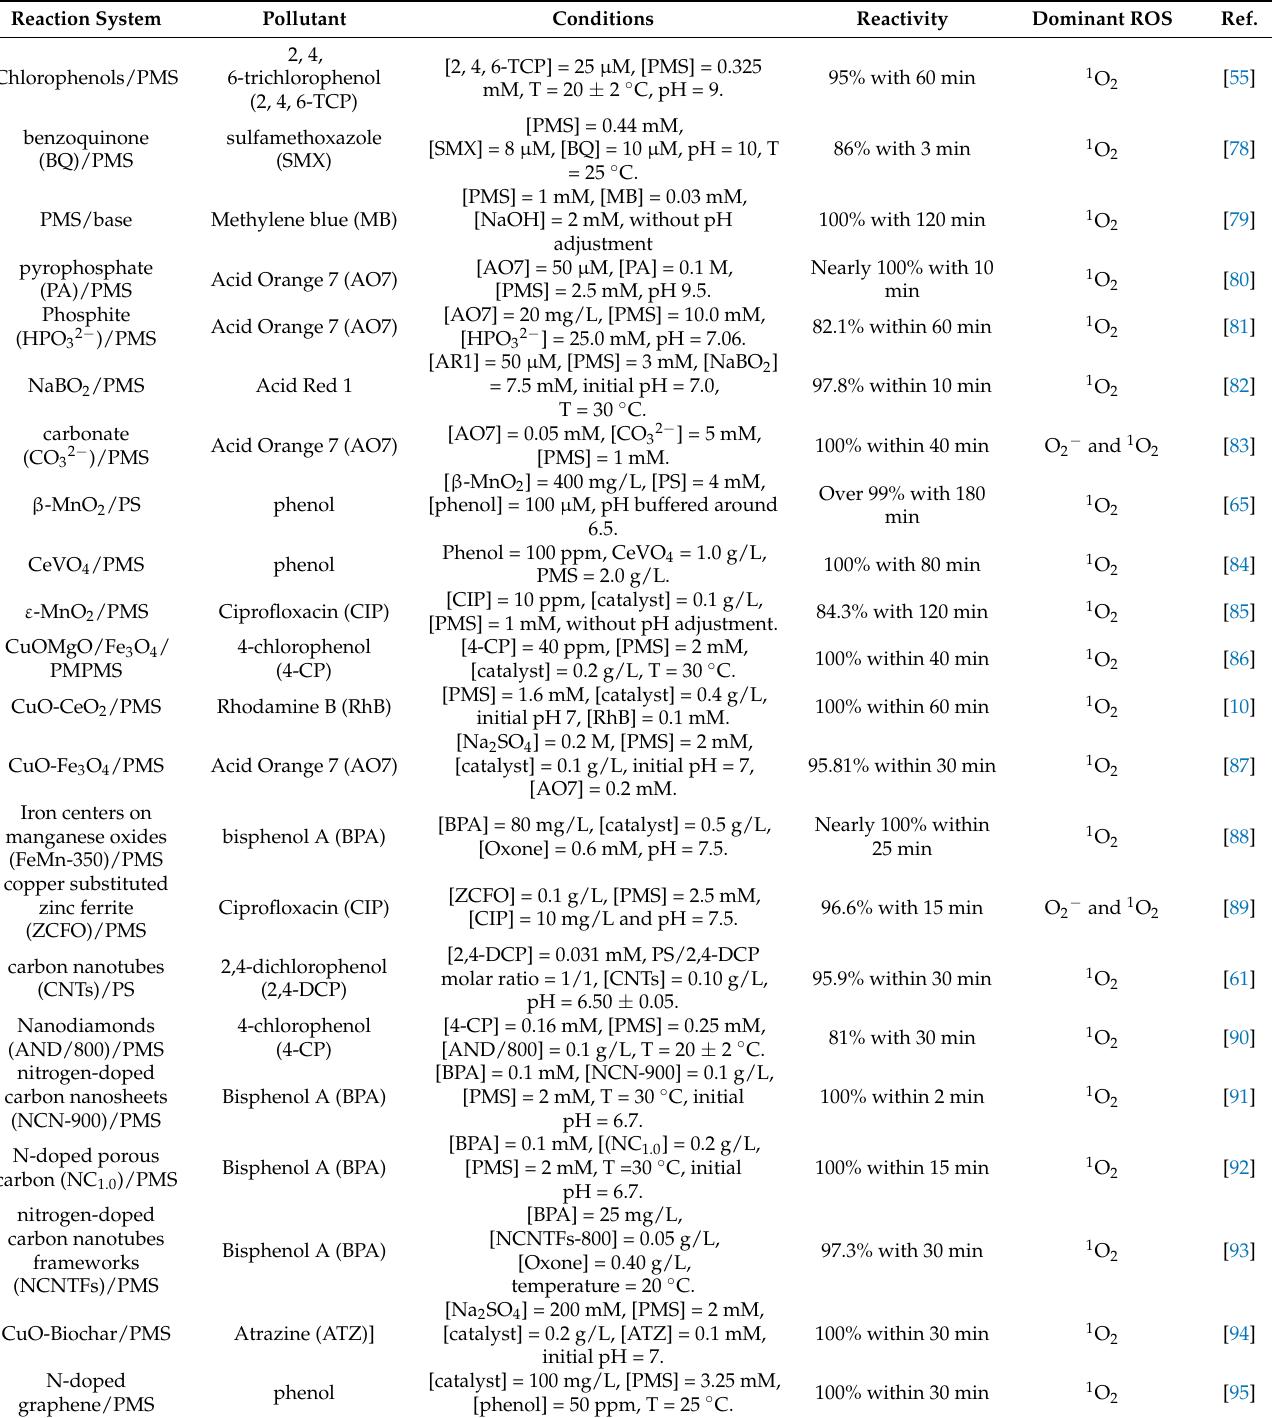
Table 3. The removal of pollutants via 1 O 2 oxidation generated by PMS and PS